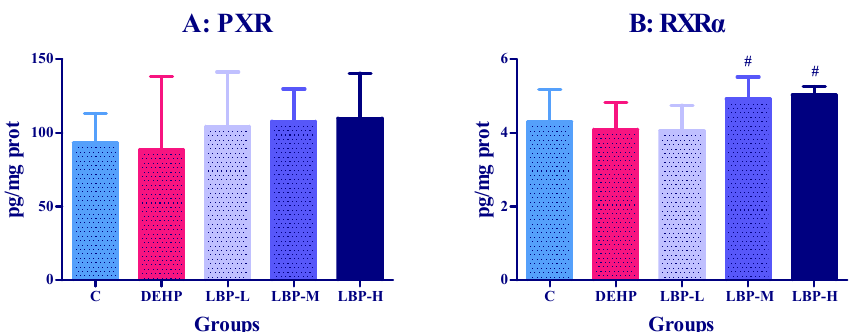
Figure 3. Effect of LBP intervention before DEHP exposure on transcriptional regulators in rats ( n = 8). Lycium barbarum polysaccharide was continuously given for seven days, and DEHP was fed on the last day. The related liver metabolic enzyme activities (PXR and PXR α ) were determined by ELISA kit. ( A ) or ( B ): concentrations of RXR or PXR α . Data are expressed by mean ± S.D. The significance of difference among treatment groups was determined by one-way ANOVA. #: compared with DEHP group, p < 0.05.